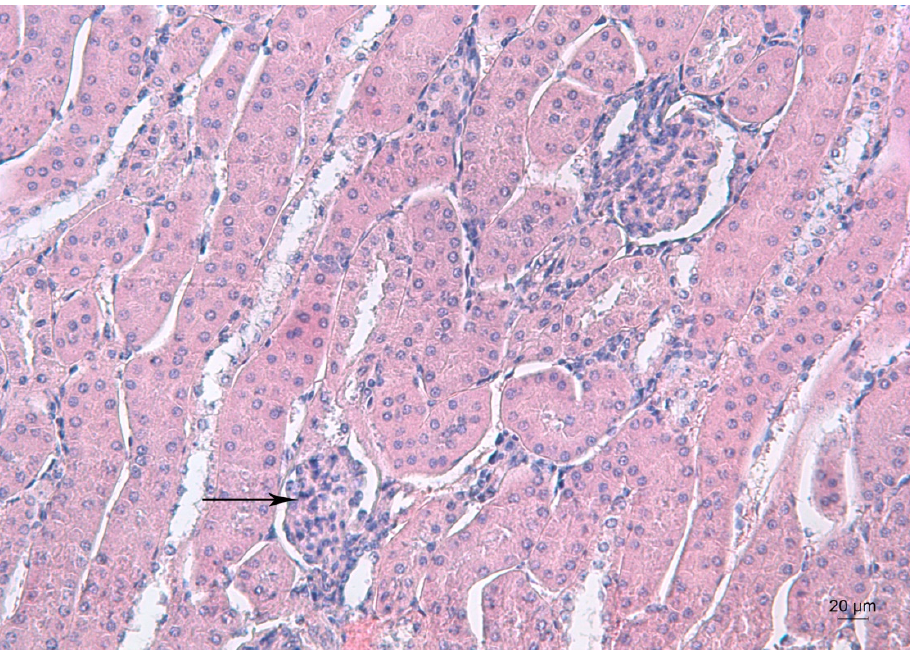
Figure 3. Representative photomicrograph of a kidney section of a control mouse. Arrow denotes the renal glomerulus. HE staining, ×200.